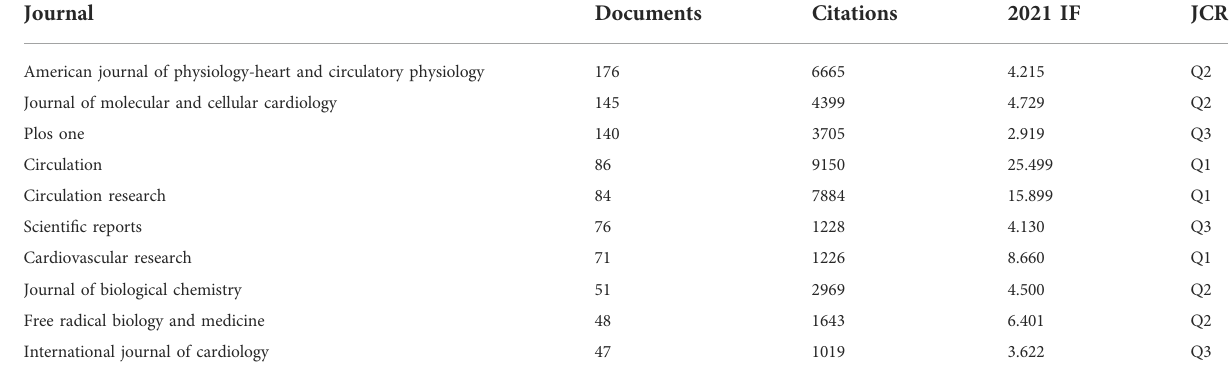
TABLE 4 Top 10 journals related to mitochondrial function and heart failure